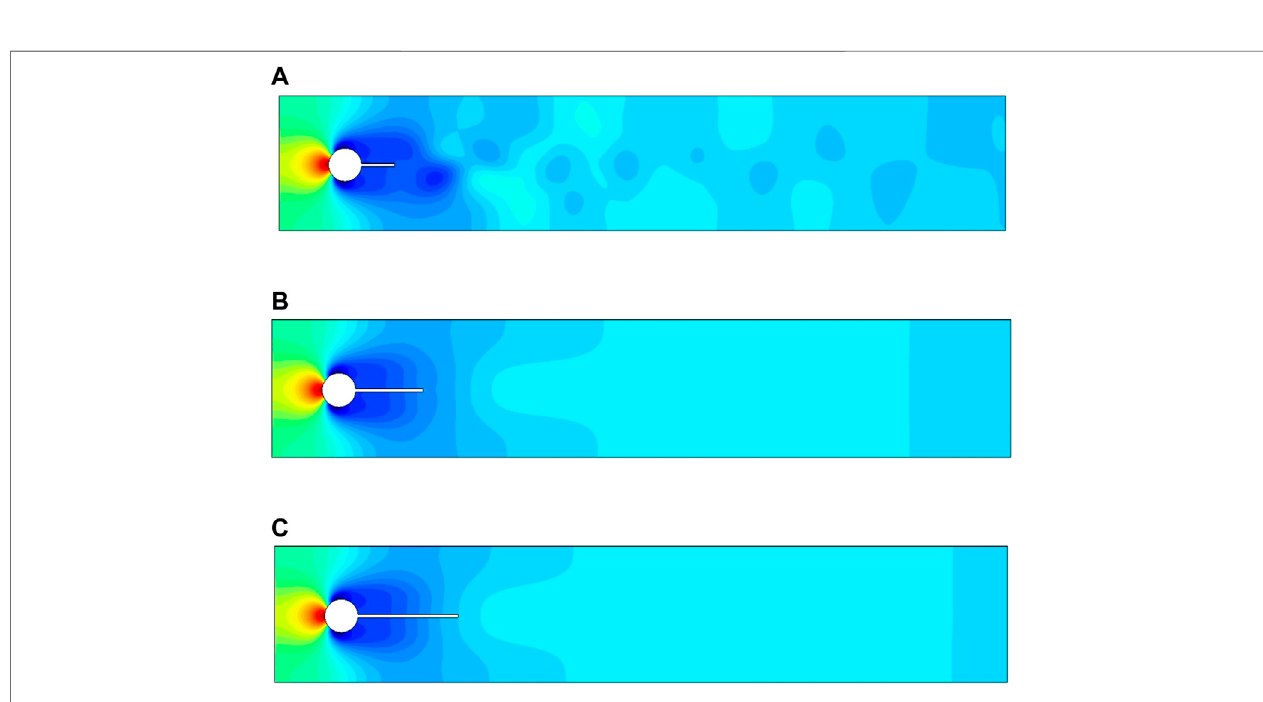
FIGURE 7 | In fl uence of attached splitter plates on pressure, of length (A) L 1 = 0.1 , (B) L 2 = 0.2 , (C) L 3 = 0.3 with Re (cid:1) 100 at (cid:2) t (cid:1) 10 .